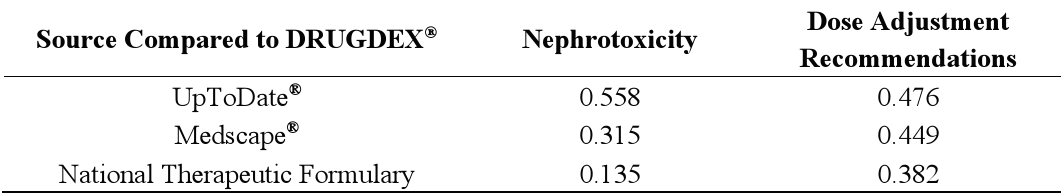
Table 2. Measures of pairwise concordance of the binary variables for the presence * or absence of citations for nephrotoxicity and dose adjustment recommendations among the four sources of